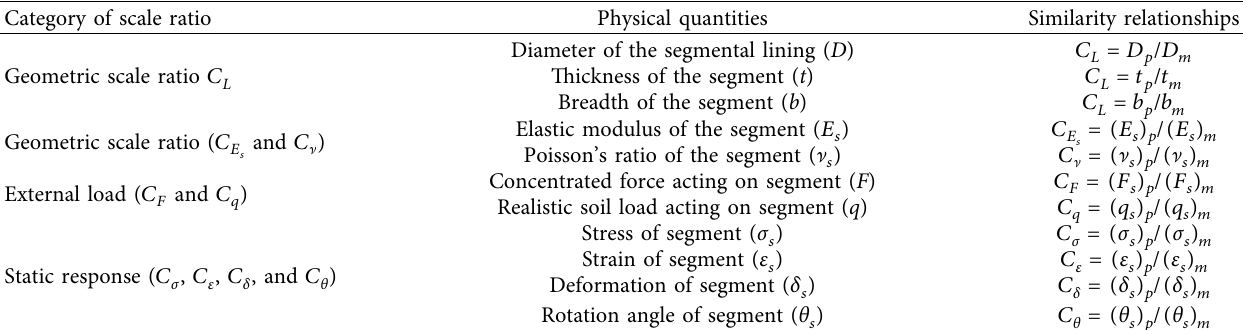
Table 1: Similarity relationships of the